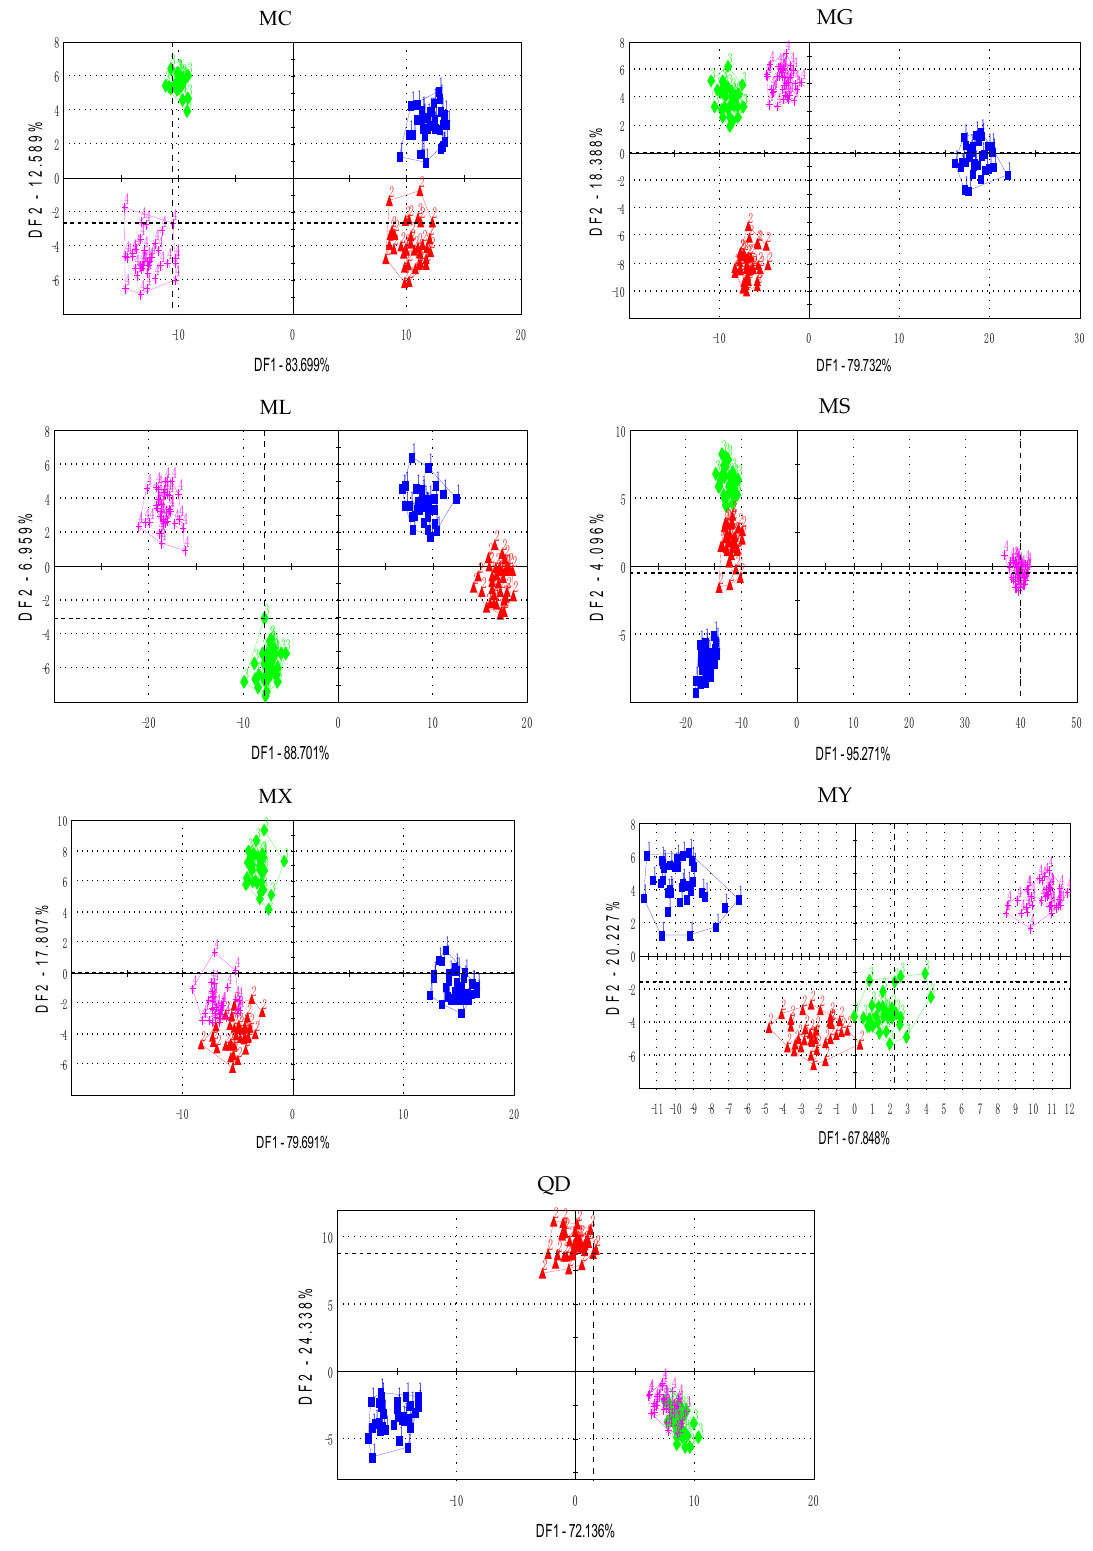
Figure 2. Score plot of the E-nose ( a ) maximum value (MV) ( b ) fused feature.